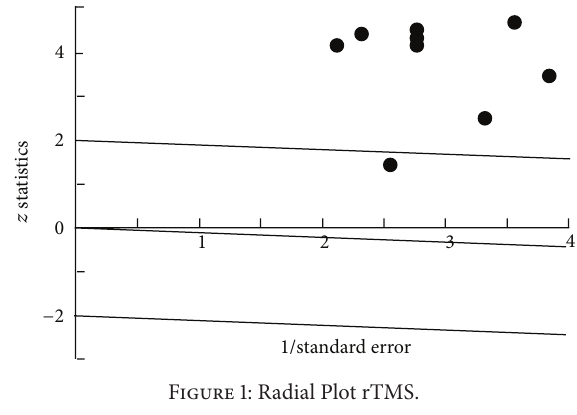
Figure 1: Radial Plot